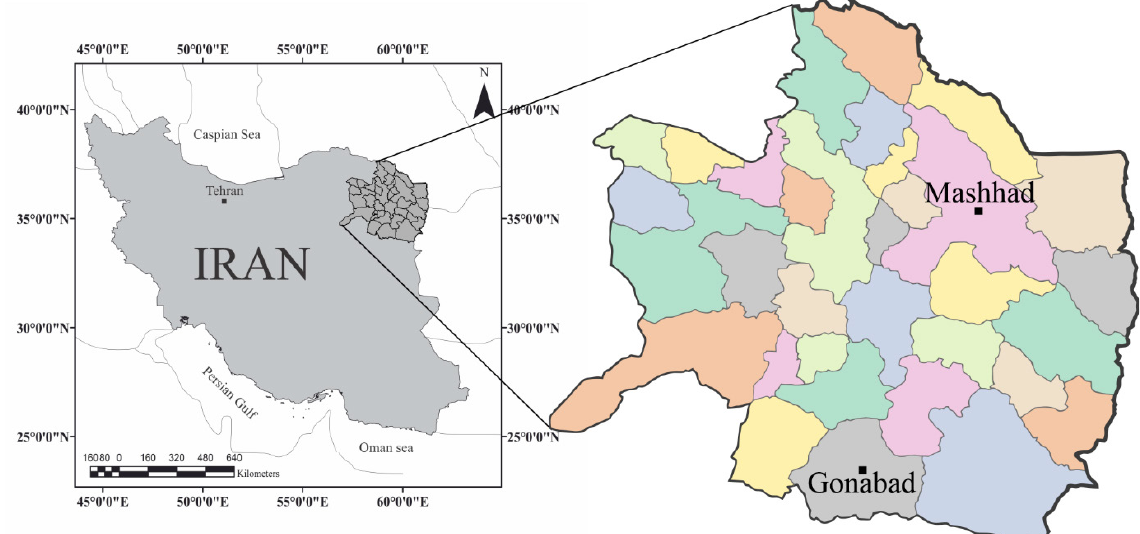
Figure 1. The geographical location of Gonabad city, Razavi Khorasan Province,